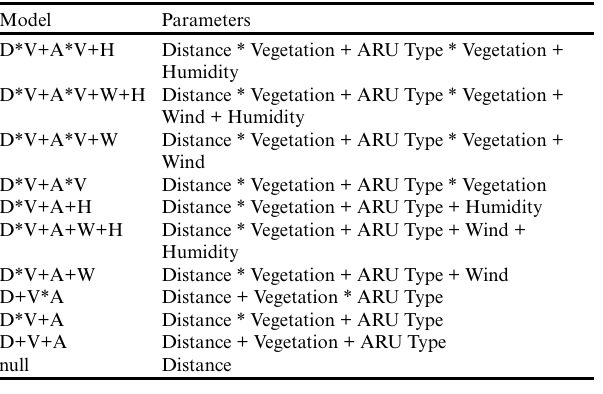
Table 1 . Candidate models to be compared against a null distance model for the autonomous recording units (ARUs)